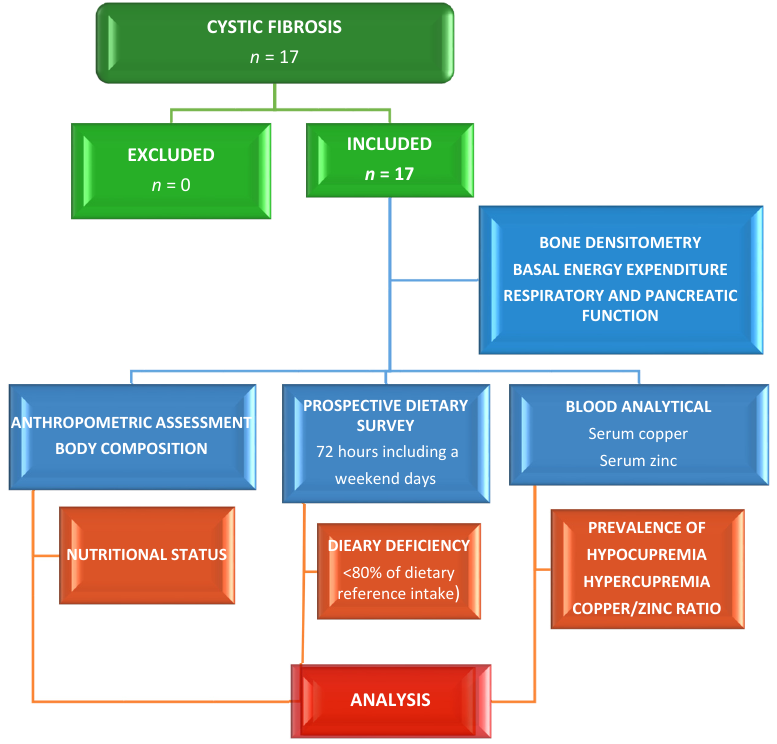
Figure 1. Flowchart of the cross-sectional study.